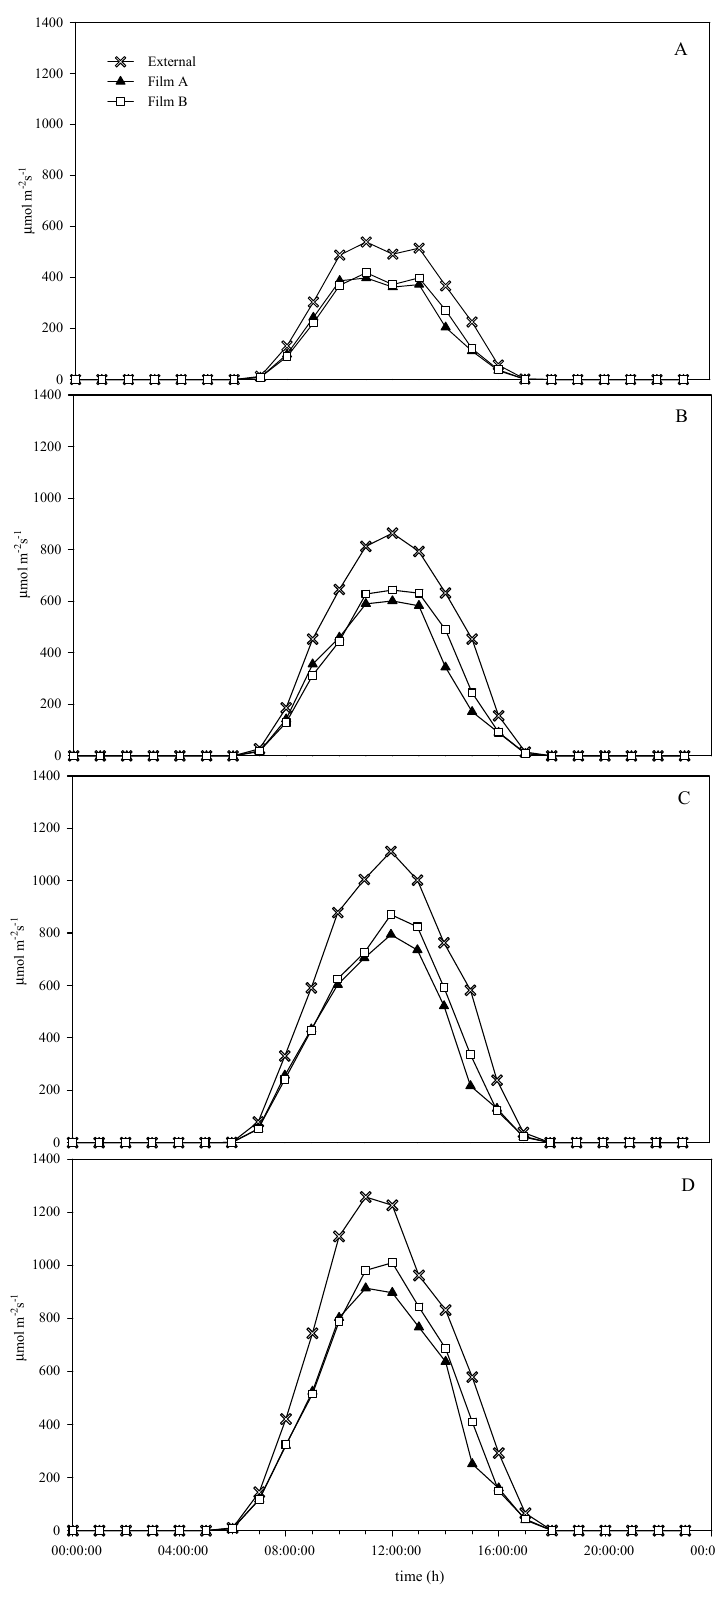
Figure 1. Hourly day mean value of light intensity in the PAR (photosynthetic active radiation) during the growing period of spinach referred to 15-day intervals starting from sowing (A = 1–15 days; B = 16–30 days; C = 31–45 days; D = 46–60 days).